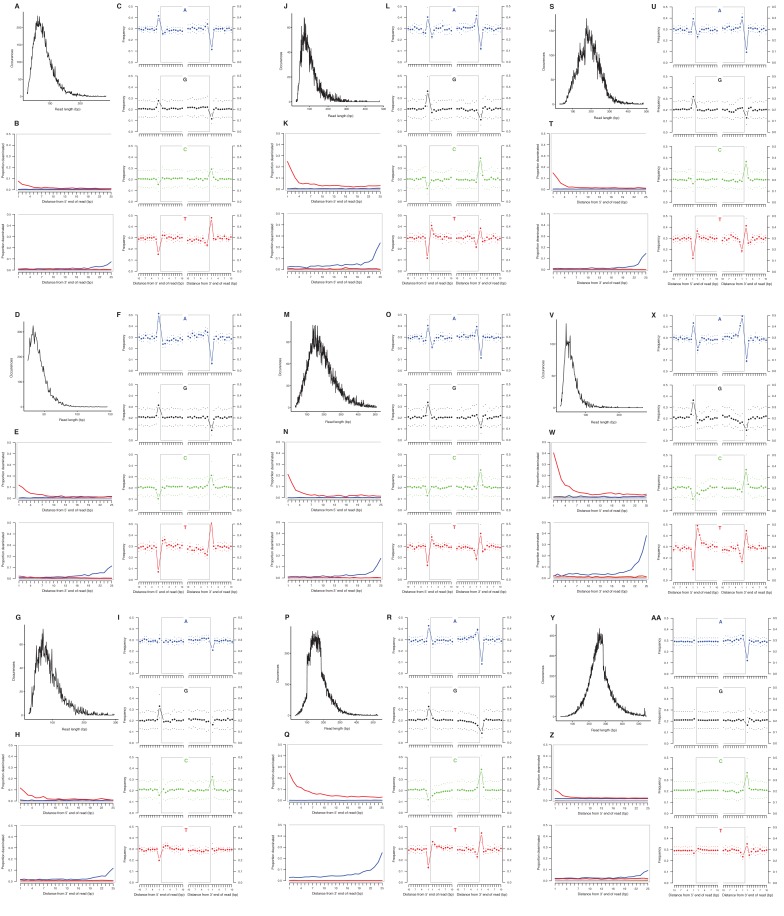
Characterization of ancient mitochondrial DNA damage patterns from nine equid samples.H. francisci: (A–C) JK166 (LACM(CIT) 109/150807; Nevada), (D–F) JK207 (LACM(CIT) 109/156450; Nevada), (G–I) JK260 (KU 47800; Wyoming), (J–L) PH013 (YG 130.6; Yukon), (M–O) PH047 (YG 404.663; Yukon), (P–R) MS272 (YG 401.268; Yukon), (S–U) MS349 (YG 130.55; Yukon); E. cf. scotti: (V–X) PH055 (YG 198.1; Yukon); E. lambei: (Y–AA) MS316 (YG 328.54; Yukon). Every third panel: (A) to (Y) DNA fragment length distributions; (B) to (Z) proportion of cytosines that are deaminated at fragment ends (red: cytosine → thymine; blue: guanine → adenine); and (C) to (AA) mean base frequencies immediately upstream and downstream of the 5’ and 3’ ends of mapped reads.